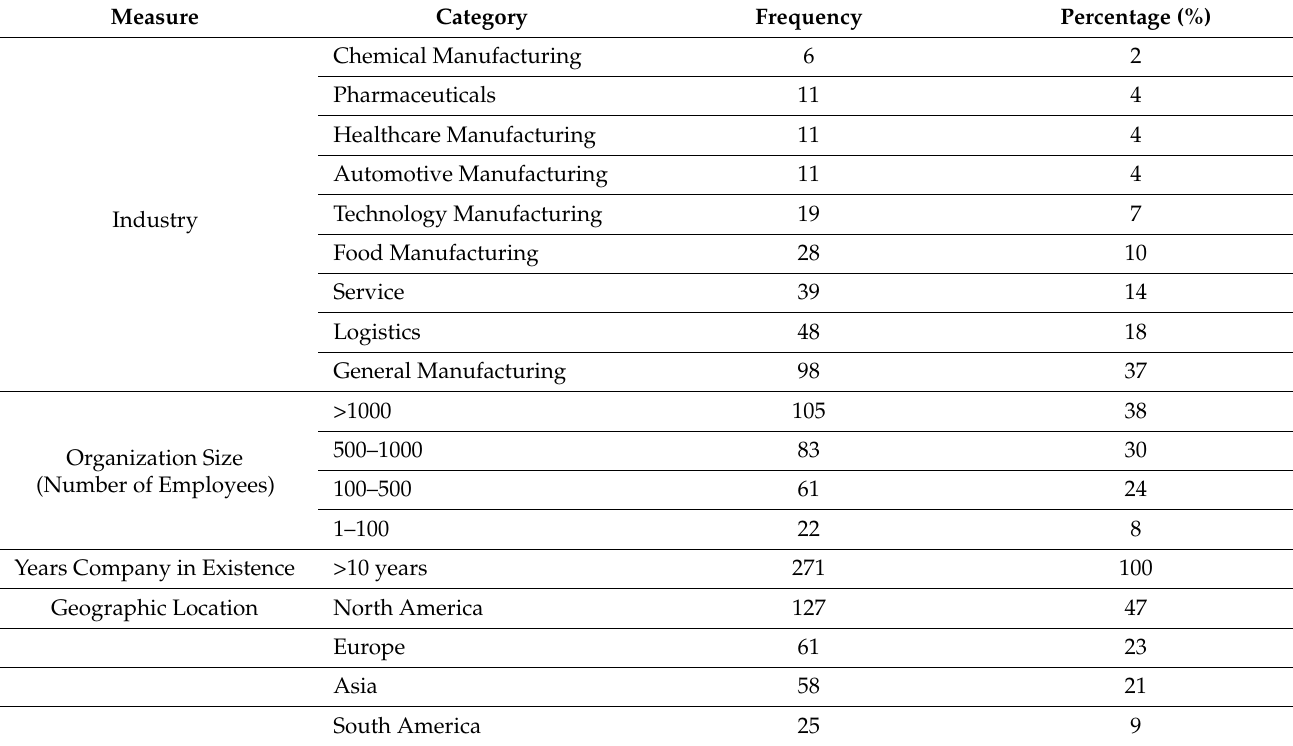
Table 1. Demographic Profile of